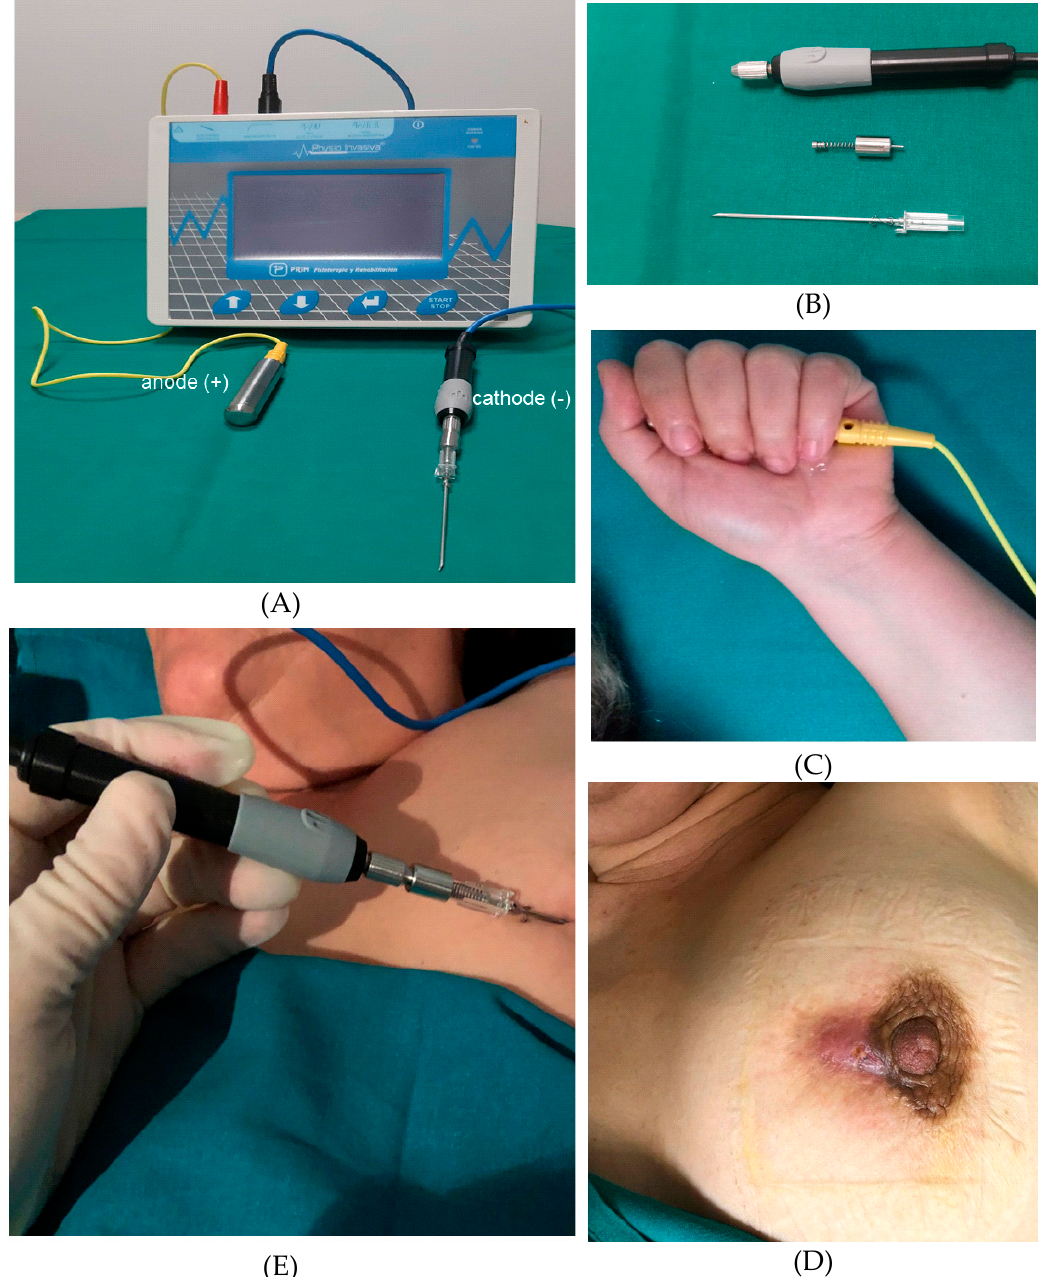
Figure 1. ( A ) Percutaneous needle electrolysis (PNE) unit employed in the study and electrodes; ( B ) needle holder (cathode), adapter to connect the needle to the needle holder and needle with the safety shield moved to the base of the needle; ( C ) patient holding a hand-held anode; ( D ) 46-year-old woman with a mammary fistula (MF); (E) PNE treatment.